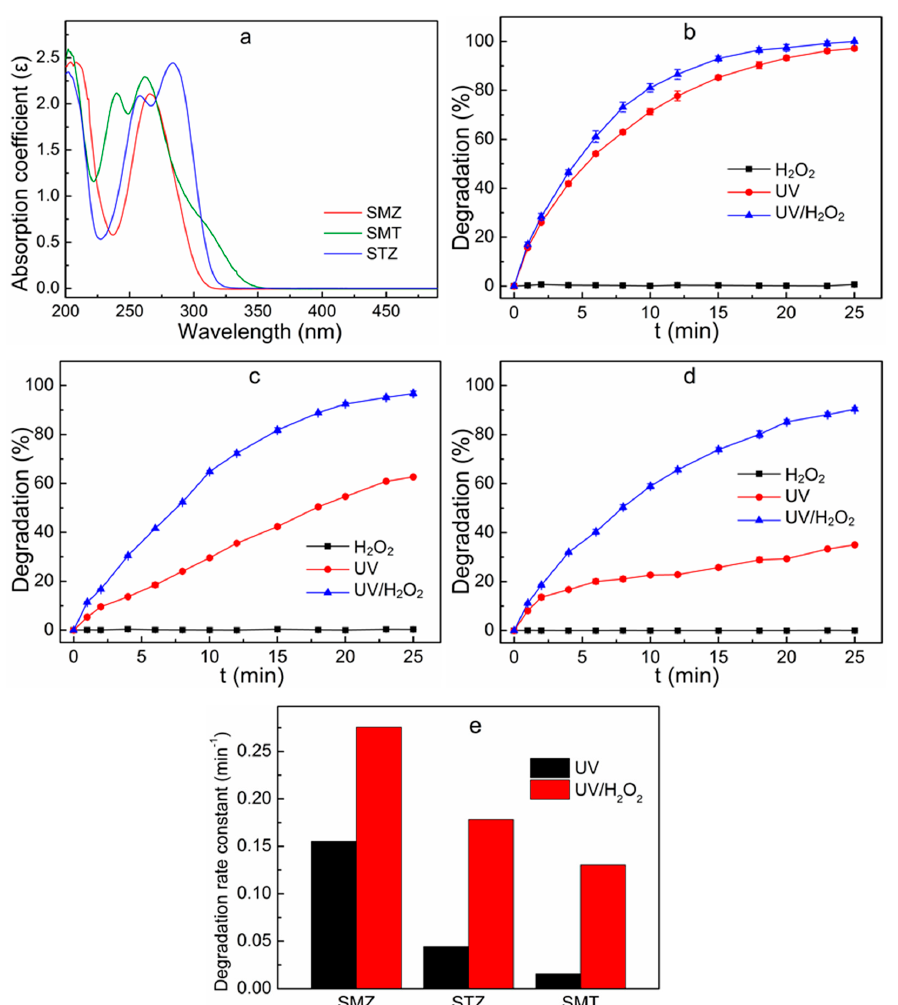
Figure 1. UV spectrum scans of sulfonamides ( a ), degradation of SMZ ( b ), STZ ( c ) and SMT ( d ) in different oxidation treatments, and degradation rate constants for sulfonamides degradation at different oxidation treatment ( e ). Reaction conditions: initial concentration of the mixed solution 100 μ g L − 1 (including SMZ 100 μ g L − 1 , STZ 100 μ g L − 1 and SMT 100 μ g L − 1 ), UV light intensity 5 W, H 2 O 2 dosage 55 mg L − 1 .